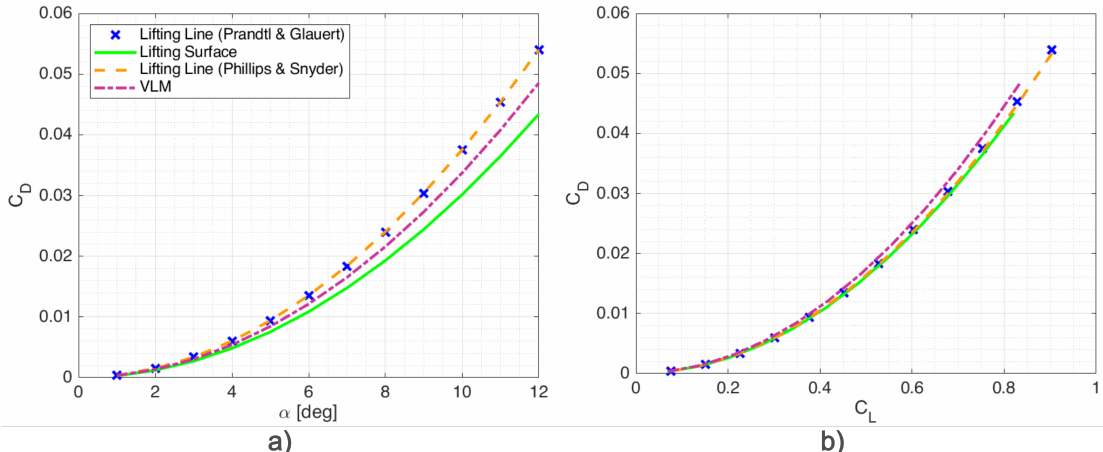
Figure A2. Induced drag coefficient as a function of angle of attack ( a ) and lift coefficient ( b ). The results of the modified LLT match those from the classical LLT, as would be expected. Whilst the induced drag predictions for the LS and VLM appear to under predict the induced drag as a function of angle of attack, it can be seen that this is due to the lower lift prediction shown in Figure A1. As a function of lift coefficient, the induced drag coefficient prediction from the LS model agrees well with the LLT prediction, whilst VLM slightly over predicts the induced drag